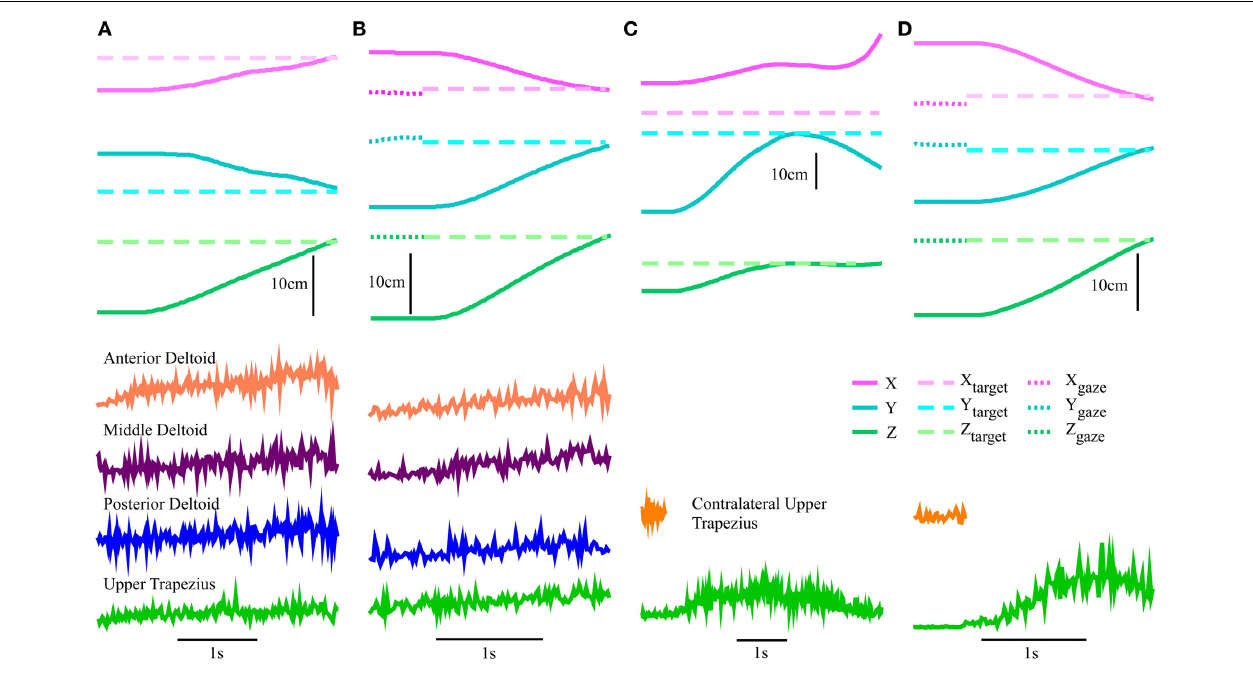
FIGURE 5 | Robot-assisted reach trajectories and the signal sources used to generate them. Kinematics and square-root transformed root-mean-squared value (RMS) of EMG for an example reach. Subject 3 with